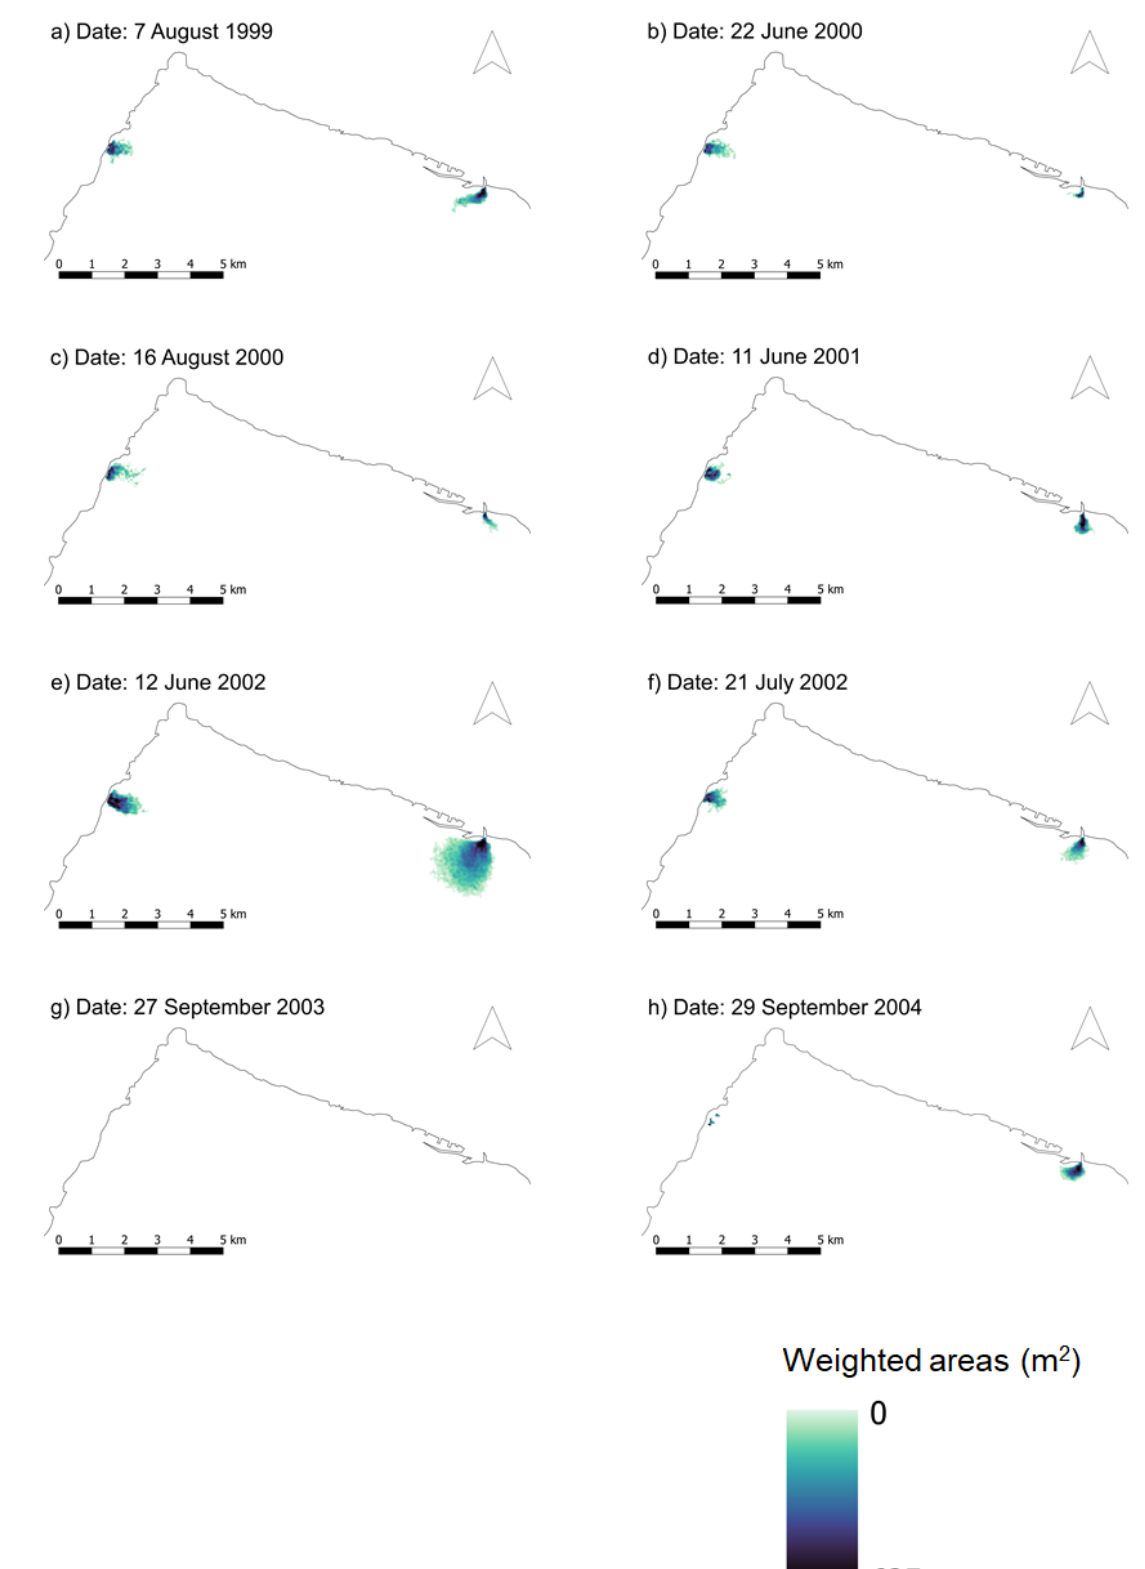
Figure 4. ( a – h ) Spatial distribution of the weighted areas for the selected images.